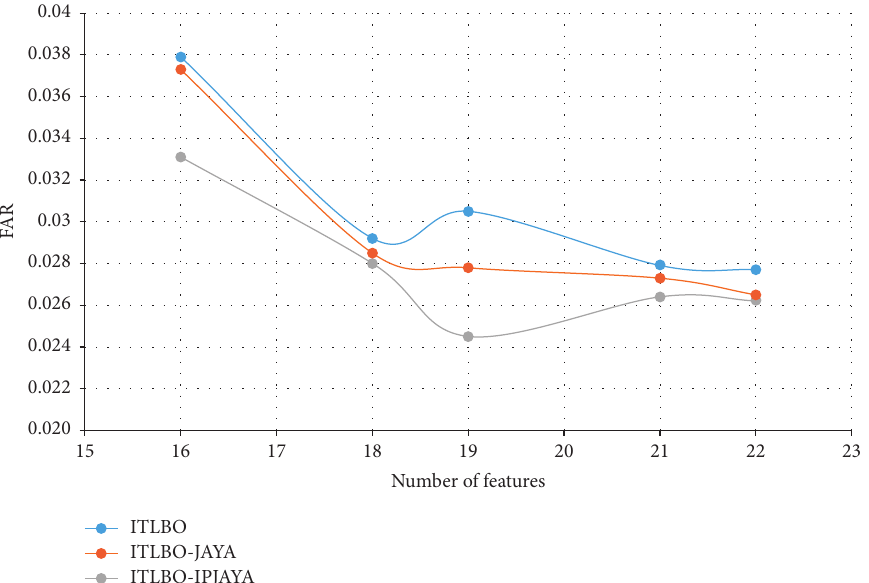
Figure 14: Comparison based on the number of features head for the NSL-KDD dataset. Table 12: Comparison of ITLBO, ITLBO-JAYA, and ITLBO-IPJAYA for the CICIDS dataset. No. of